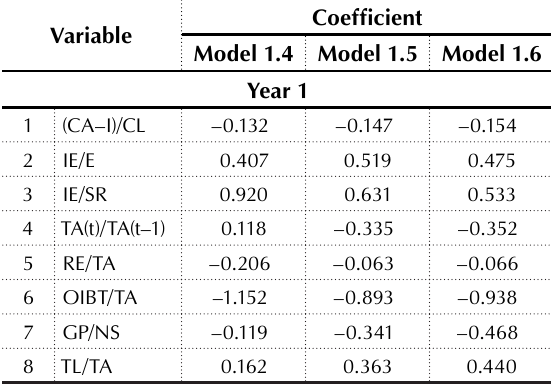
Table 3. Stepwise selection results for logistic regression models – variable set 2